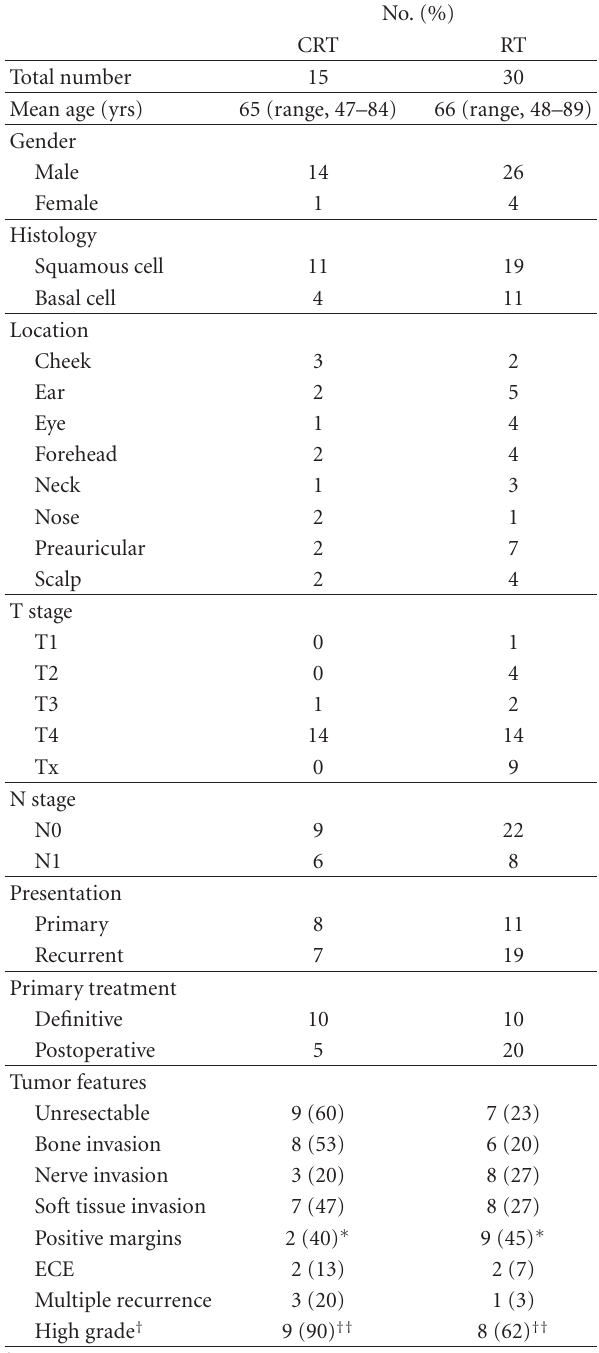
Table 1: Patient and primary tumor characteristics.